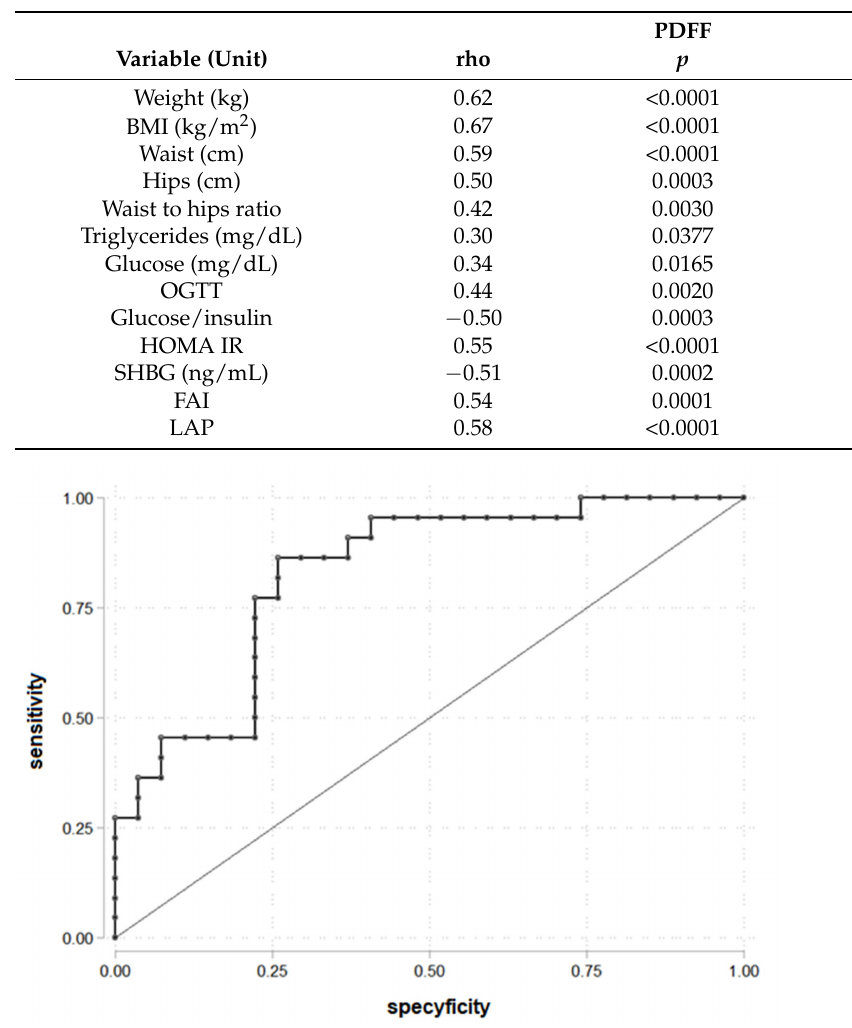
Table 2. Statistically significant rho-Spearman coefficient between variables and PDFF.